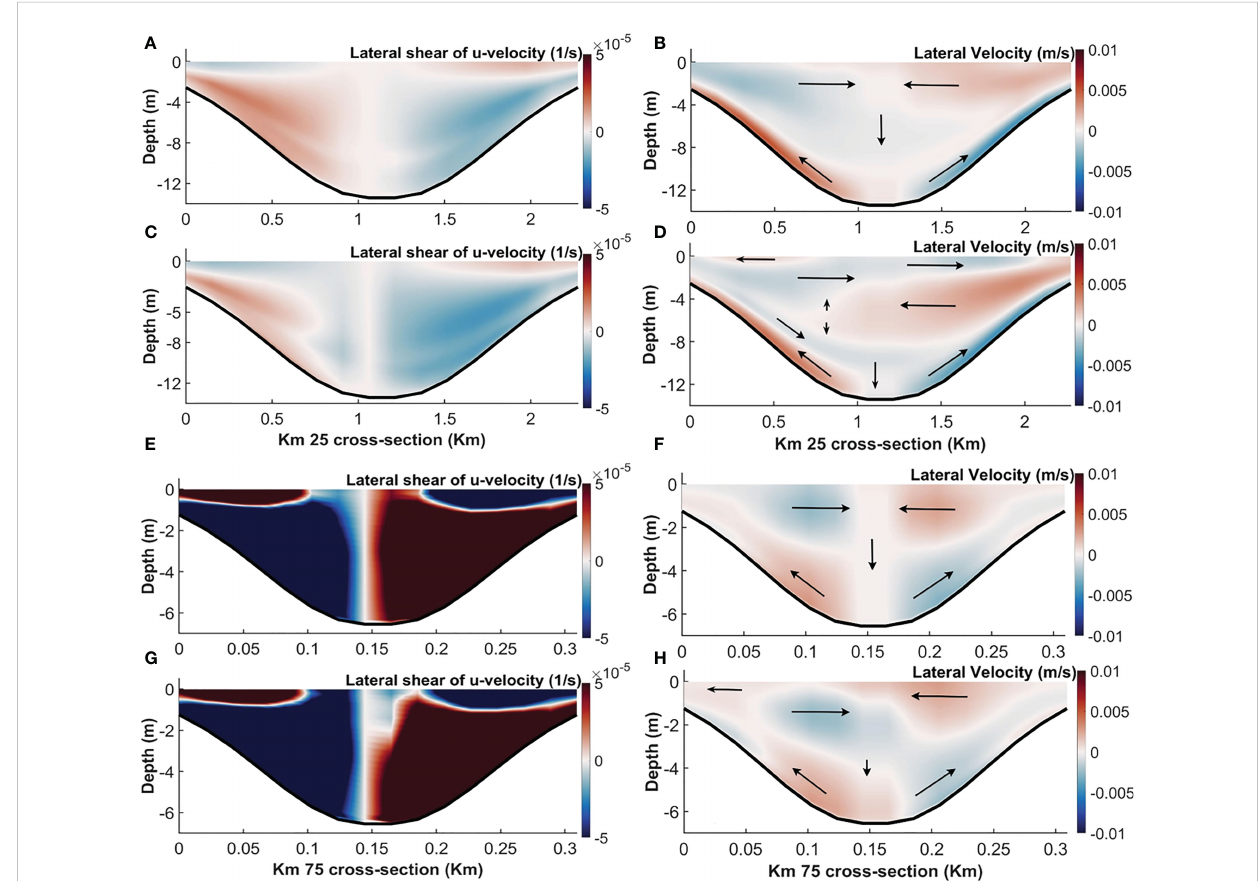
FIGURE 4 Time-averaged lateral shear of along-channel velocities ( ∂ u ∂ 75 km (E – H) from the mouth in EXP1 (A, B, E, F) and EXP6 (C, D, G, H) . Red and blue colors in lateral velocities represent leftward and rightward velocities, respectively, looking into the